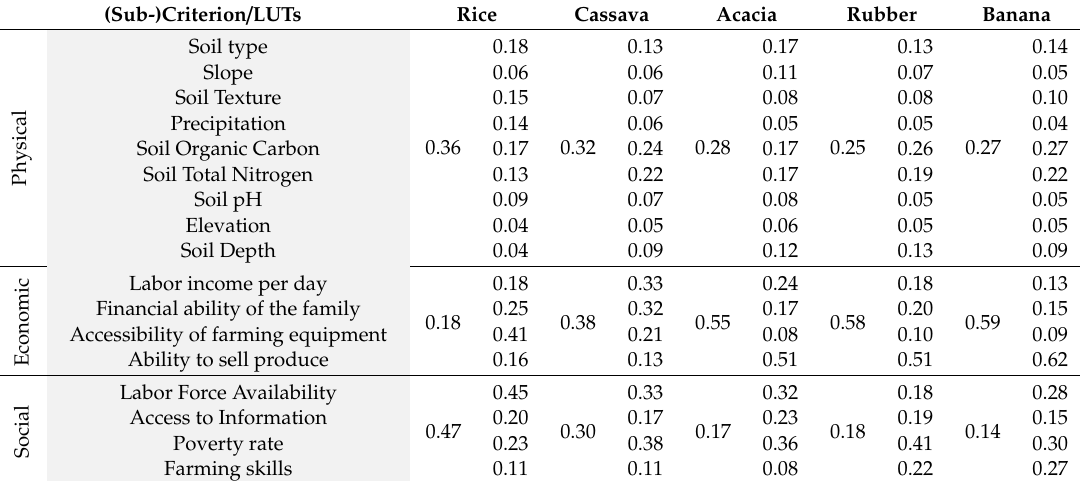
Table 8. Weights of overall Criteria (bold number) and Sub-Criteria based on Analytical Hierarchy Process